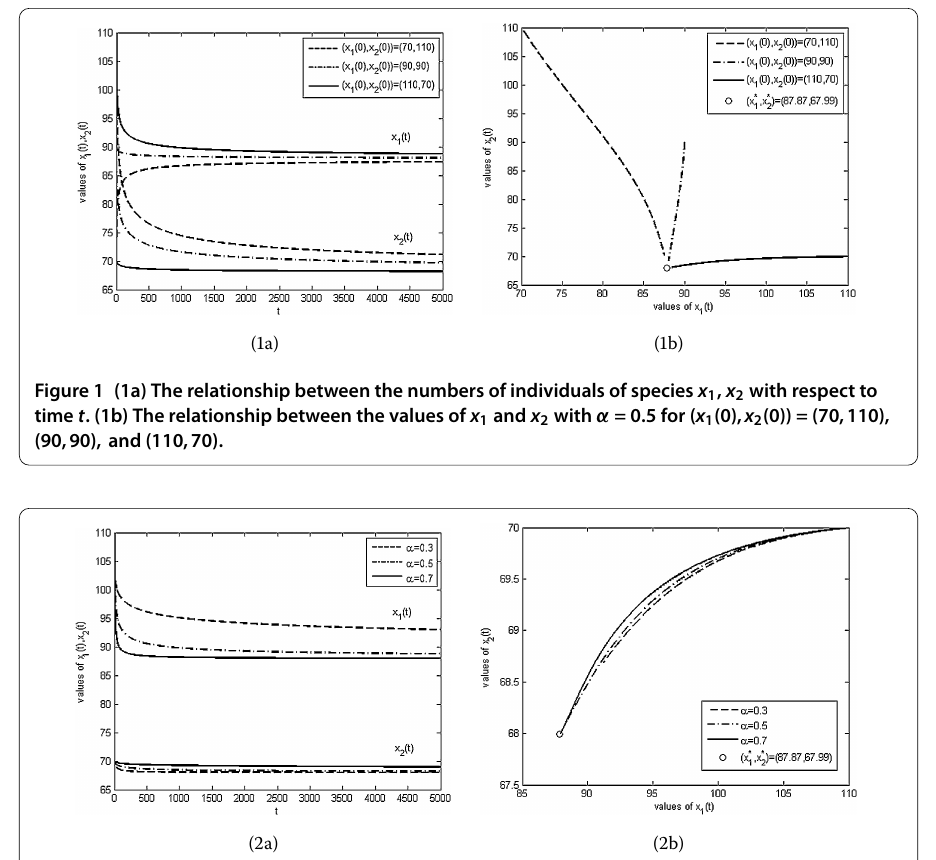
Figure 2 (2a) The relationship between the numbers of individuals of species x 1 , x 2 with respect to times t . (2b) The relationship between the values of x 1 and x 2 with ( x 1 (0), x 2 (0)) = (110,70) for α = 0.3, 0.5, and